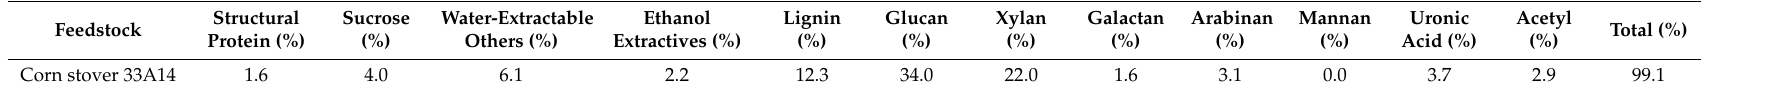
Table 4. Solids compositional analysis of native corn